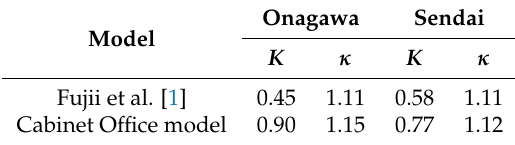
Table 1. Aida parameters calculated from both source model for each target